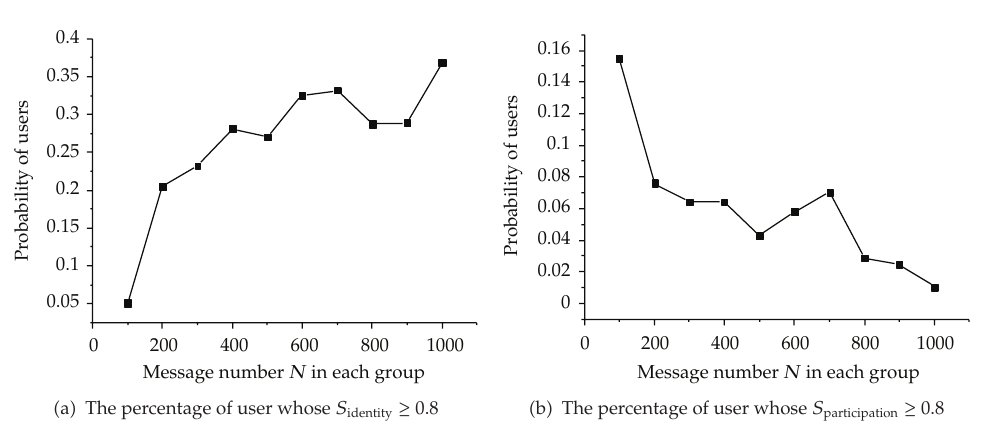
Figure 8: The percentage of user with S identity or S participation larger than threshold in each